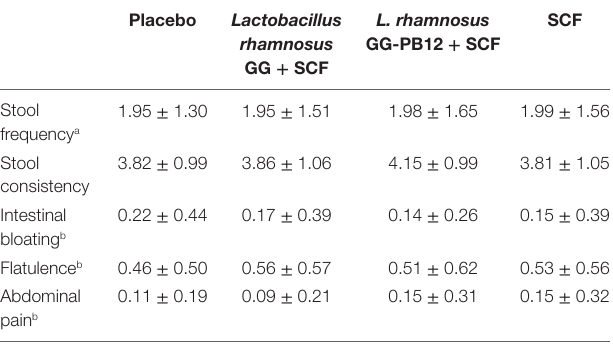
TaBlE 1 | Average, self-reported, gastrointestinal symptom scores for stool frequency, consistency, bloating, flatulence, and abdominal pain, over the 3-week intervention period for the placebo, synbiotics, and SCF for each treatment group ( n =